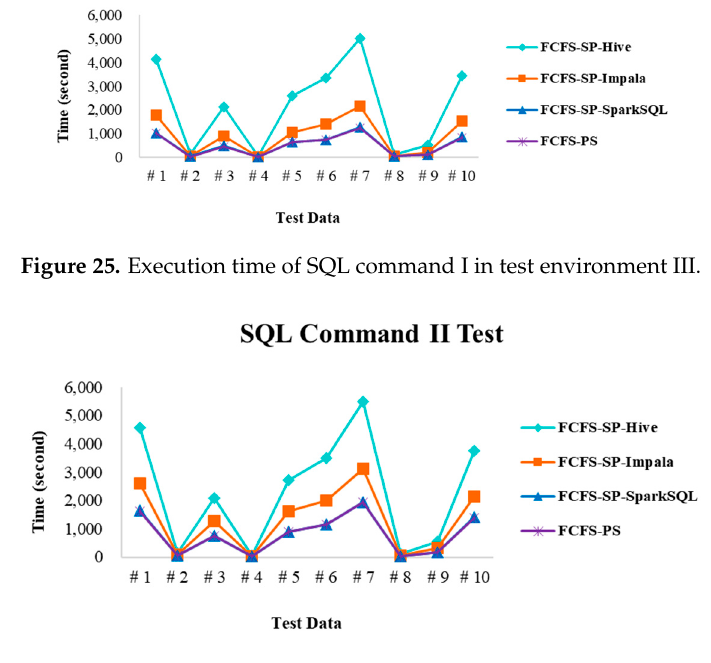
Figure 26. Execution time of SQL command II in test environment III.